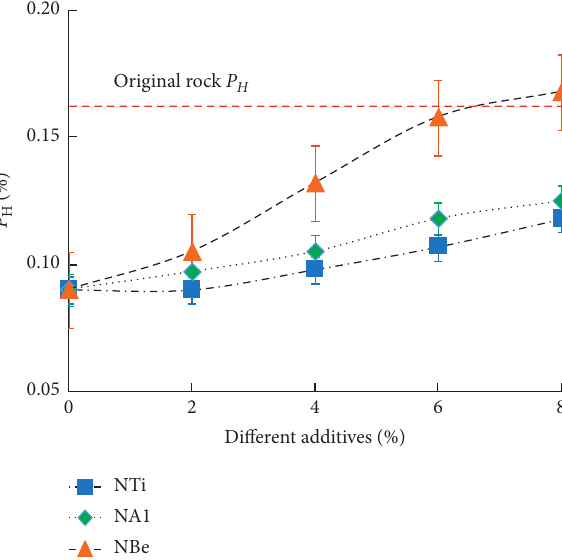
Figure 3: Effects of nanoscale additives on density parameters of similar materials.